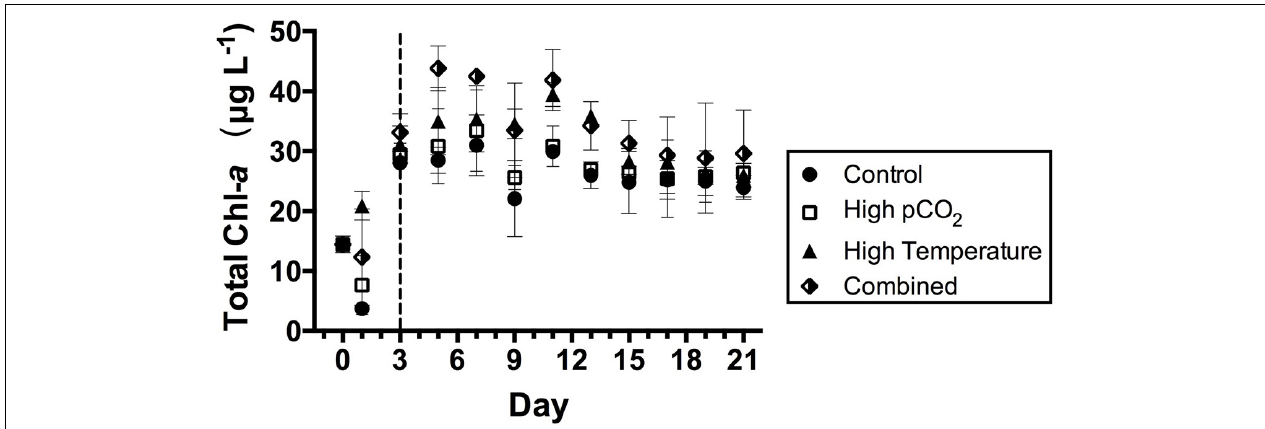
FIGURE 1 | Total Chl- a concentrations during the time course of the incubation in the four experimental treatments. Values are the means and error bars are the standard deviations of triplicates. The dashed line separates the two incubation stages: T0–T3 batch growth mode, and T3–T21 continuous growth code with dilution rate of 0.4 d - 1